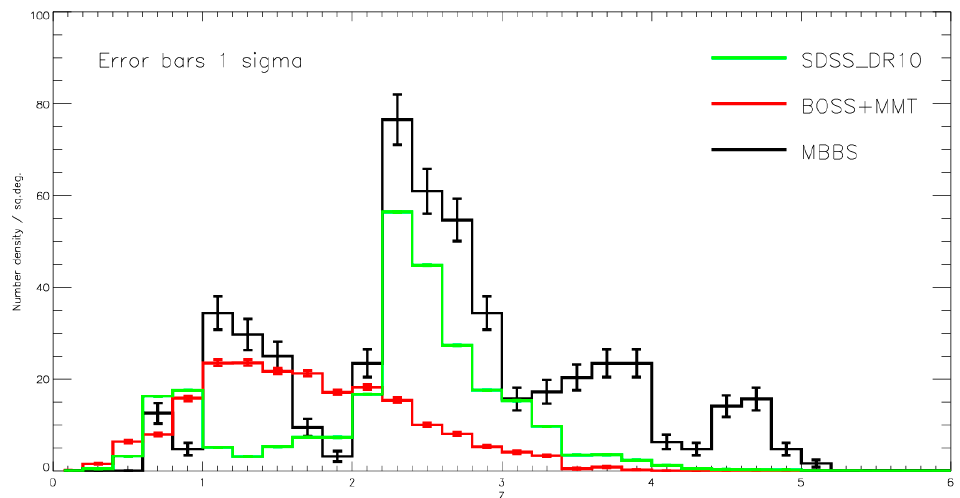
Figure 8. The number densities of quasars based on three different samples. Δ z = 0.2. The green line shows the QSO number density based on the SDSS data release 10 sample [7], and the red line shows that based on BOSS + MMT variability selection sample [6]. The black line shows the number density based on the Medium-Band Byurakan Survey sample in the SA68 field.